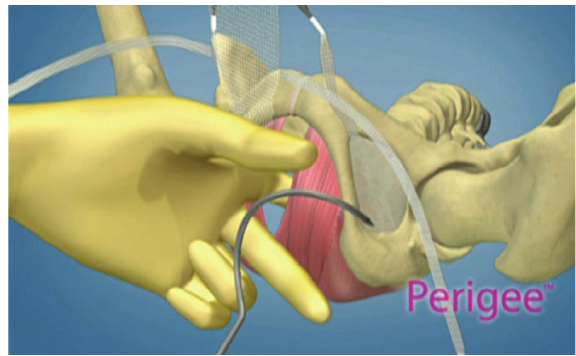
Figure 1: Inferior or “apical” needle being passed through the obturator space to attach the more apical arm of the mesh graft to the pelvic sidewall at the level of the ischial